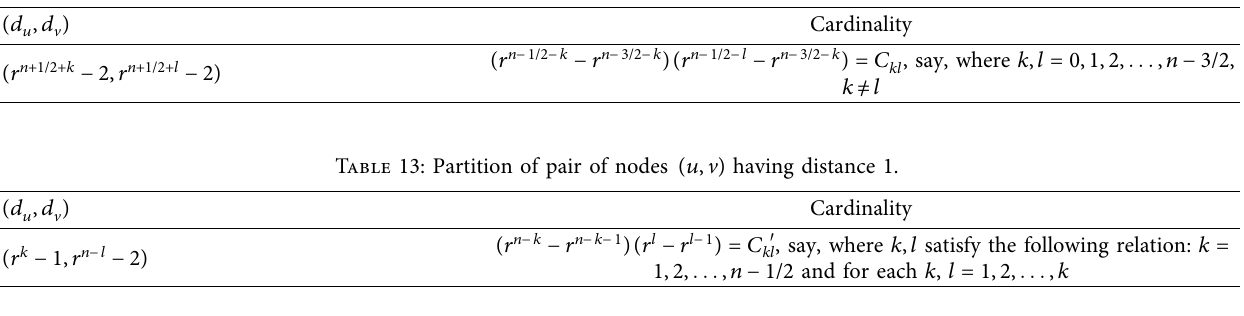
Table 12: Partition of pair of nodes ( u, v ) having distance 1.